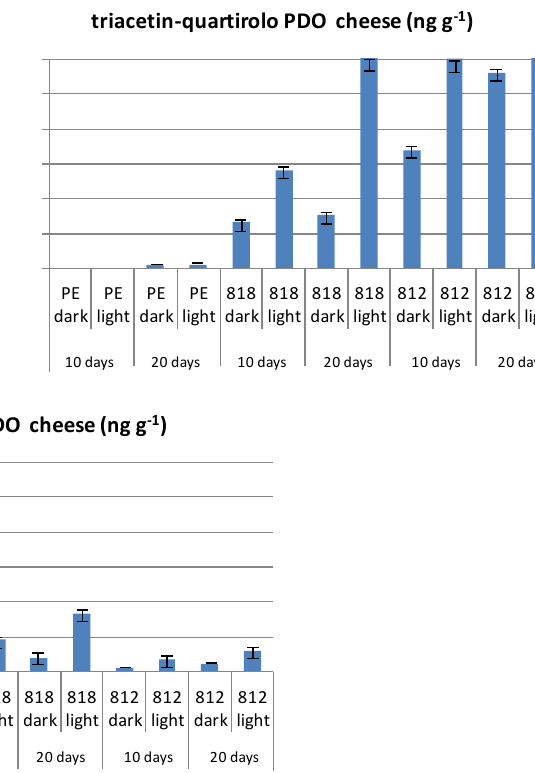
Figure 8. Levels of triacetin in PDO cheeses wrapped in different cling-films and stored refrigerated for 10 and 20 days in the dark or under fluorescent light (data expressed as ng·g −1 of